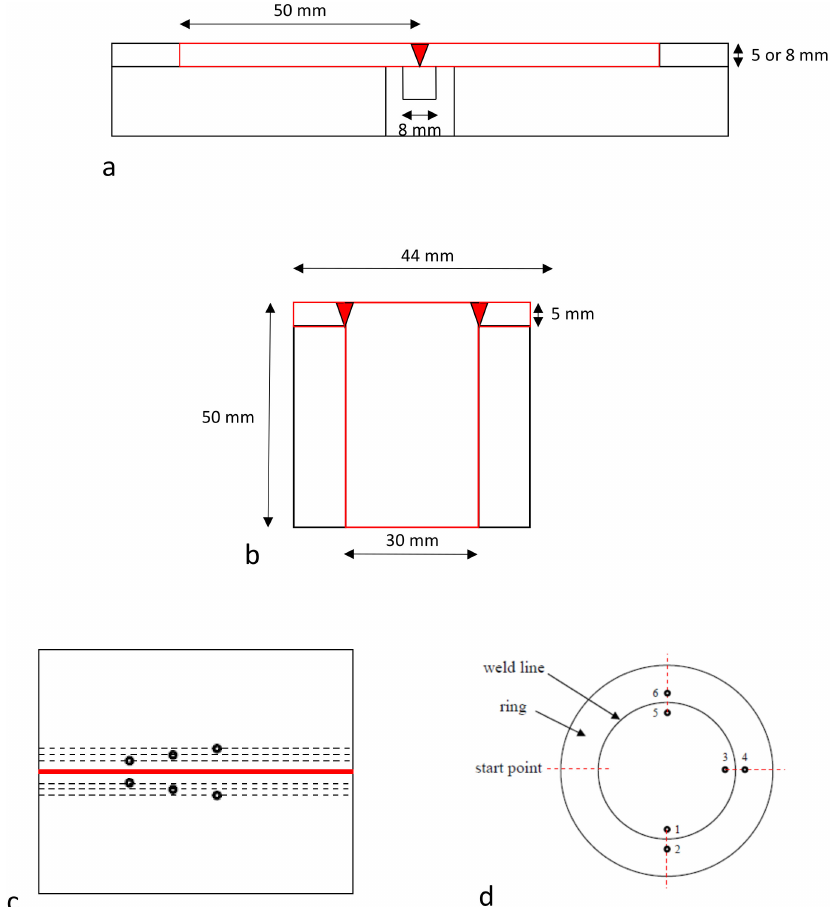
Figure 3. ( a )–( b ) Experimental set-up for the laser welding trials for the flat and circular samples, ( c )–( d ) position of the thermocouples was 2, 2.5 and 3 mm with an in-between spacing between measurements of 15